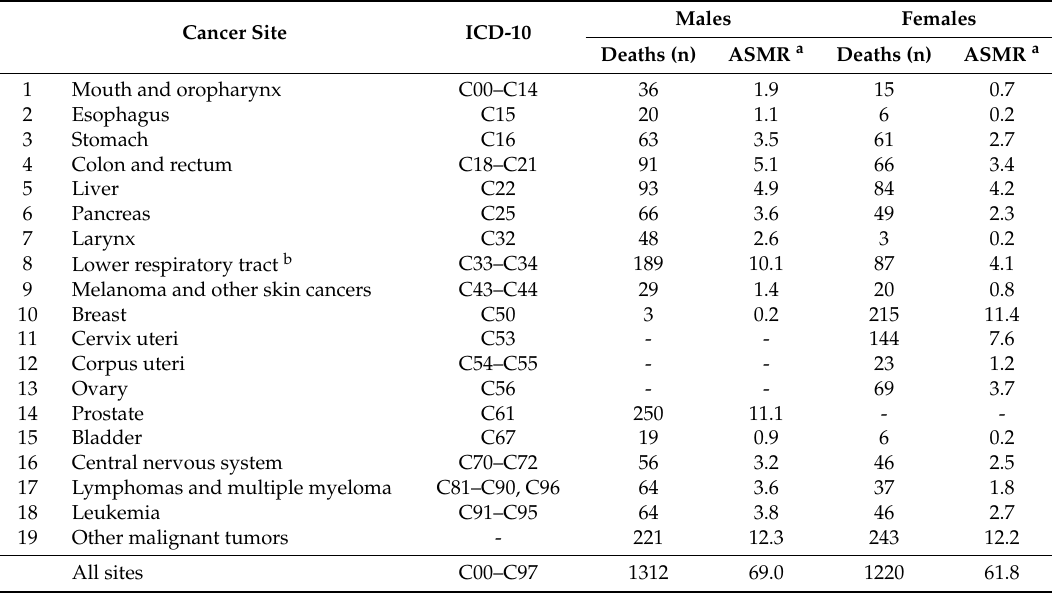
Table 1. Sex-stratified cancer mortality in the study population, Colima, Mexico